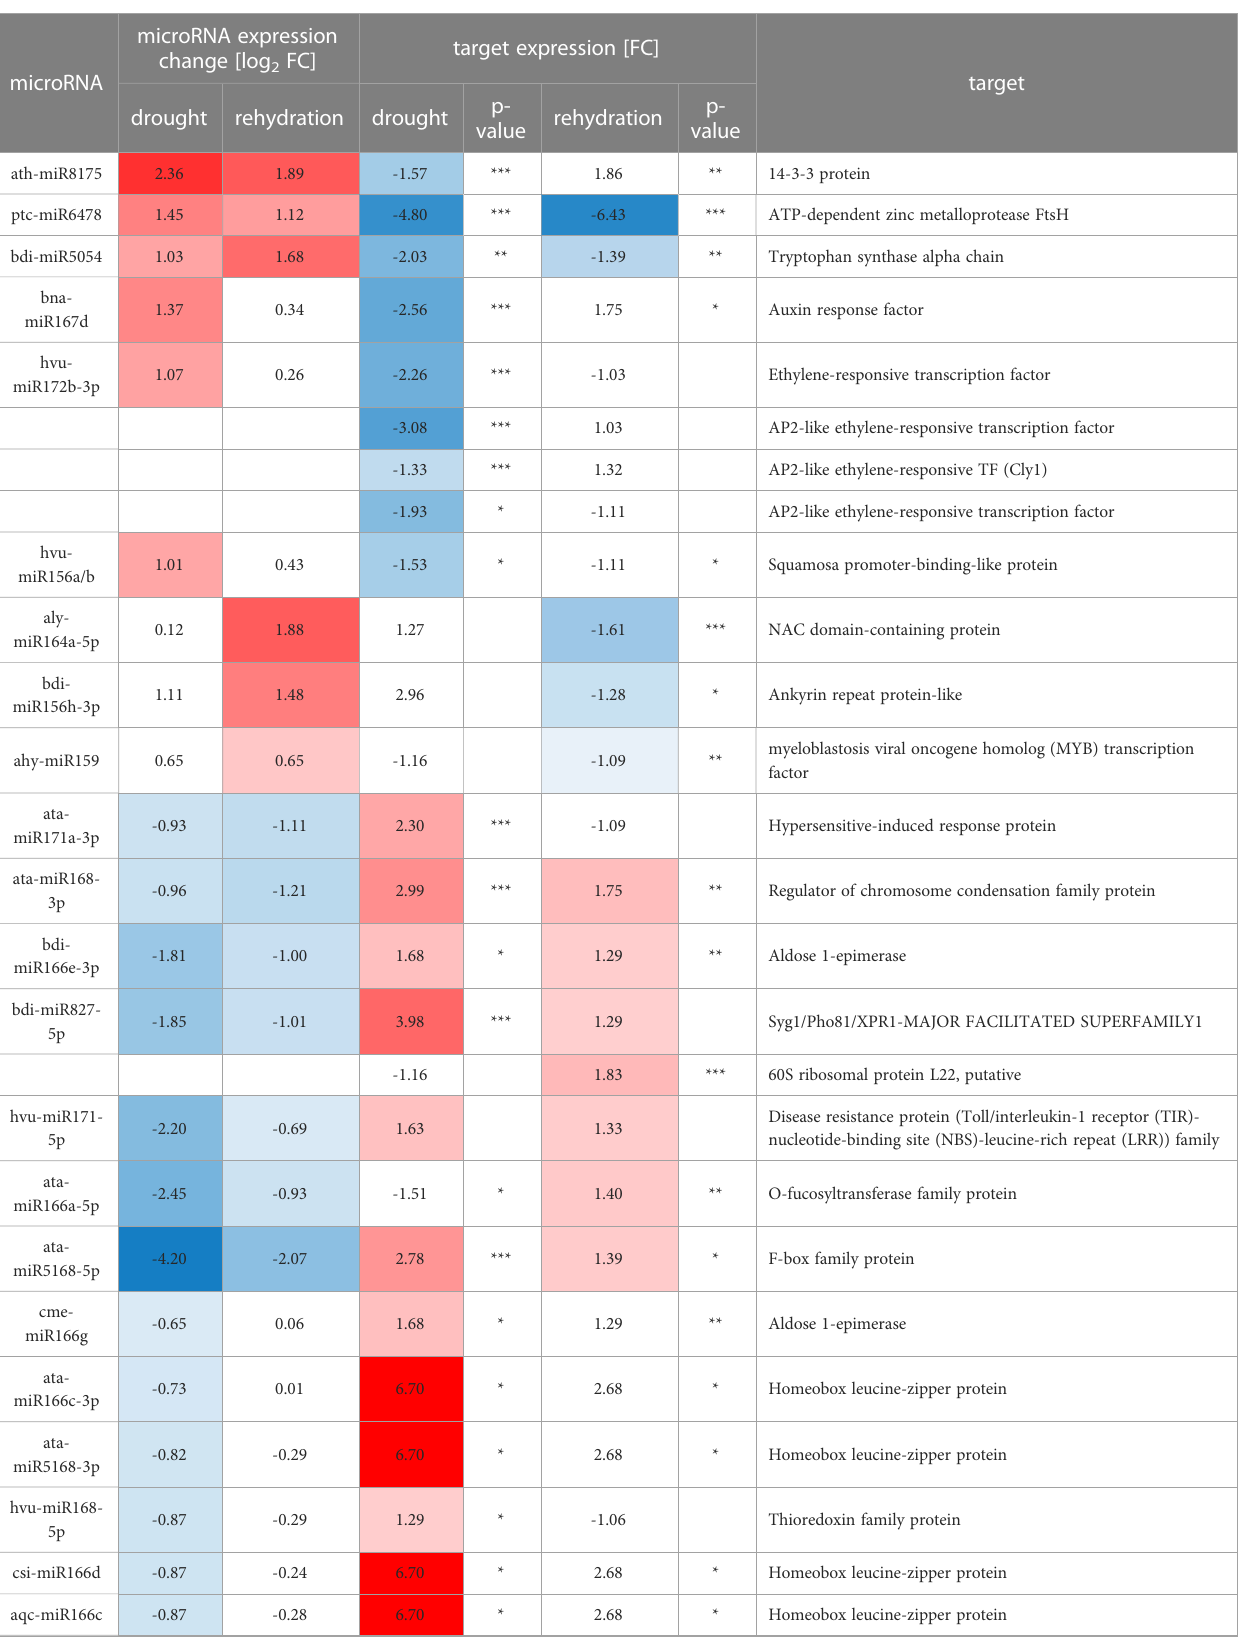
TABLE 4 Target mRNAs whose expression is controlled by miRNAs in drought and/or rehydration